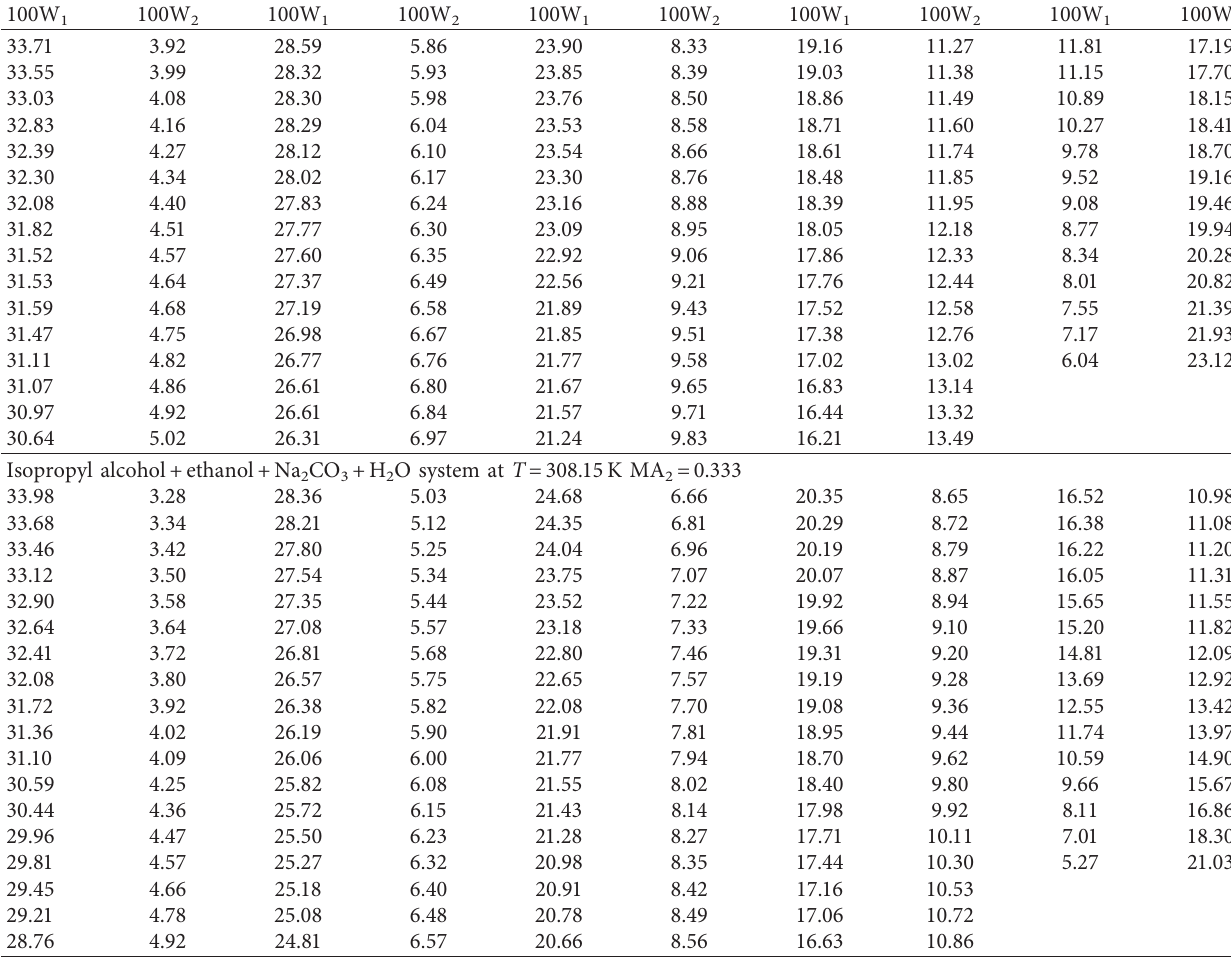
Table 3: Parameters of equation (5) for the mixture of polyethylene glycol/isopropyl alcohol +ethanol +salt (Na 2 CO 3 /Na 2 SO 4 )+water ATPSs at different temperatures. T (K) A b c R 2 sd a Polyethylene glycol +ethanol +Na 2 SO 4 308.15 0.8671 − 4.3489 Isopropyl alcohol +ethanol+ Na 2 SO 4 308.15